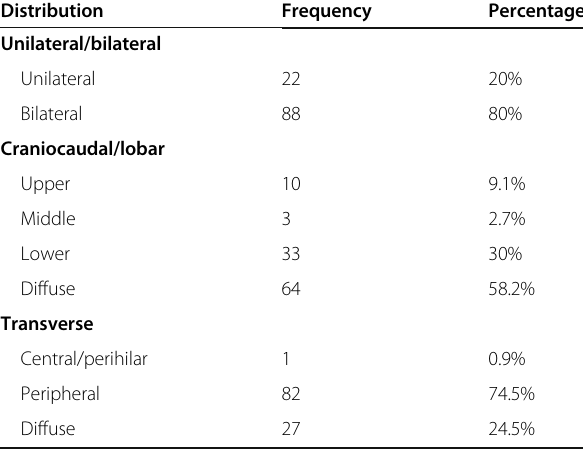
Table 1 Lesions distribution in the study cohort